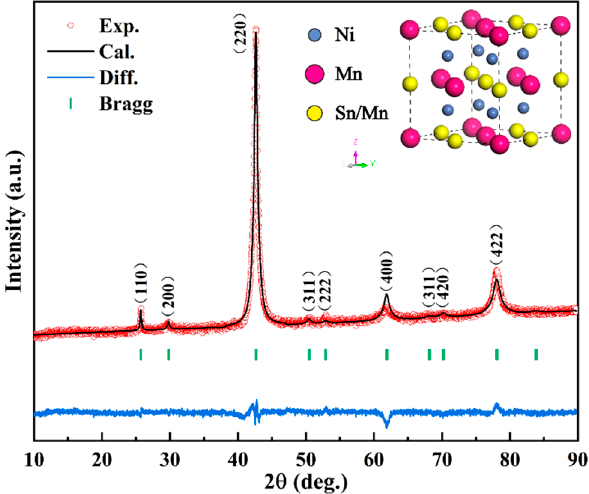
Figure 3. X-ray diffraction pattern for the Ni–Mn–Sn crystal measured at room temperature. Inset: unit cell of Ni–Mn–Sn